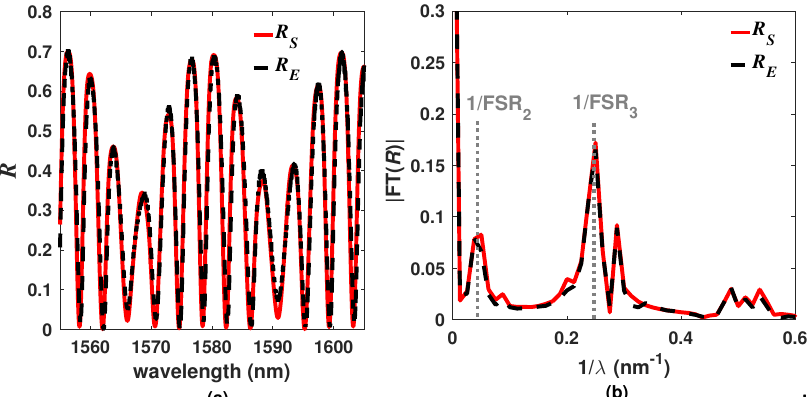
Figure 2. ( a ) Simulated ( R S ) and measured ( R E ) reflected intensity distributions patterns of the filter, considering a n 4 = 1 and T = 25°C, and ( b ) magnitude of their Fourier transforms.